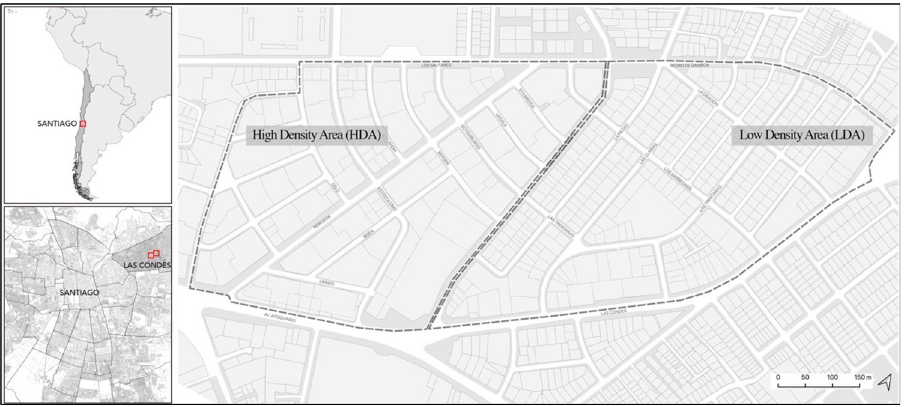
Fig 1. Observation areas. Image Source: own production based on Openstreetmap